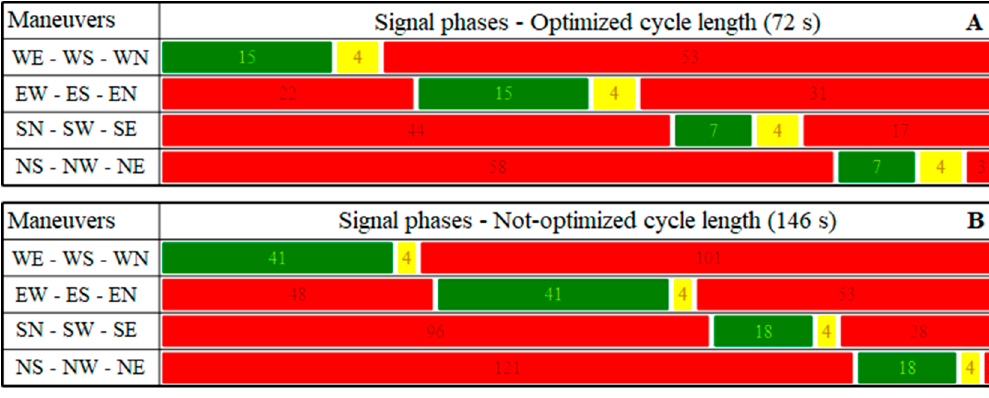
Figure 7. Traffic light Cycle A and B.